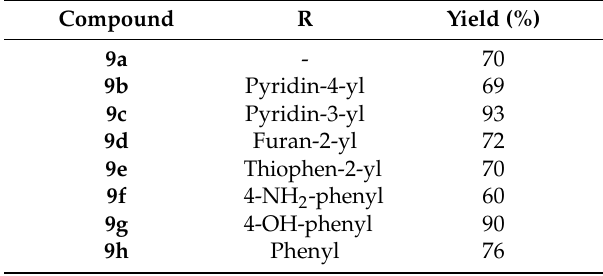
Table 1. Tripentone derivatives 9a – h .